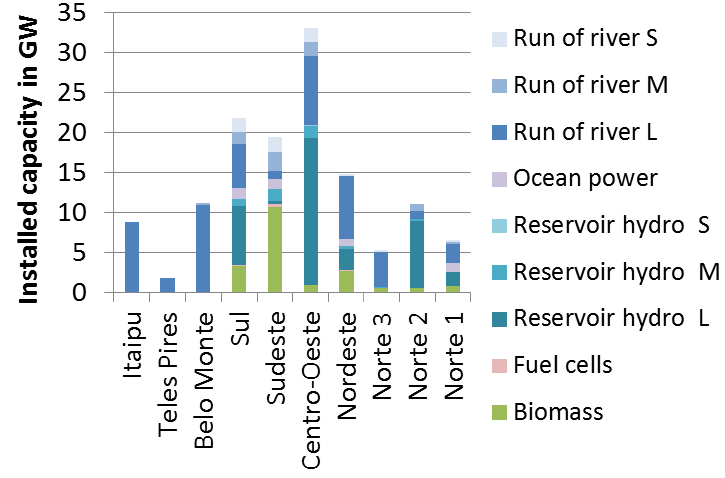
Figure 4. Exogenously defined power generation capacities for 100% renewable power supply in 2050.